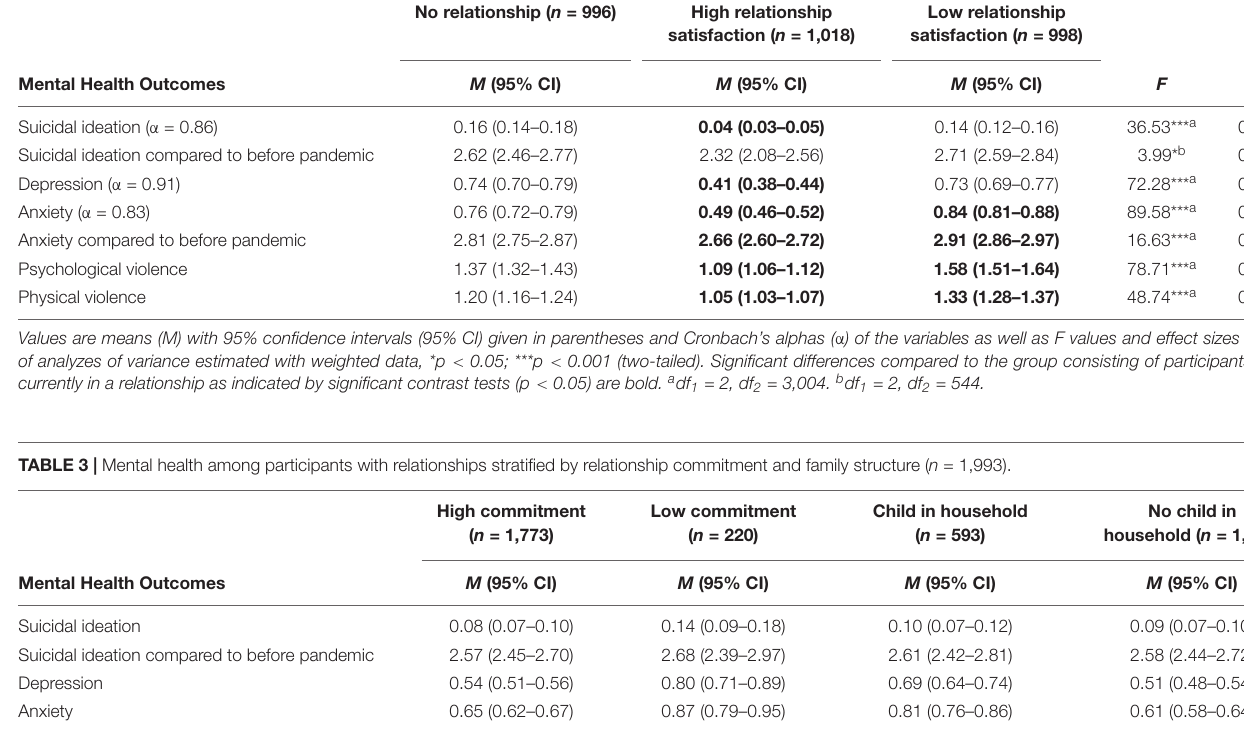
Table entries are means (M) with 95% confidence intervals (95% CI) given in parentheses estimated with weighted data.